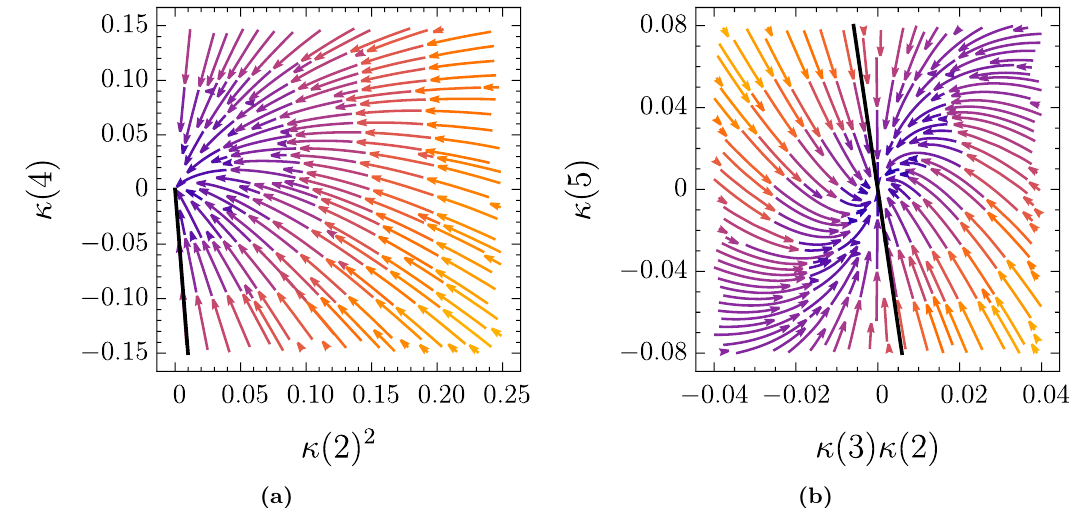
Figure 4. Renormalization group flow in pure Yang-Mills theory at fixed µ for (a) the fourth cumulant and (b) for the fifth cumulant. The arrows denote the direction of the derivatives with respect to ln µ and their color reflects their strength. The black line indicates the eigenvector of the evolution